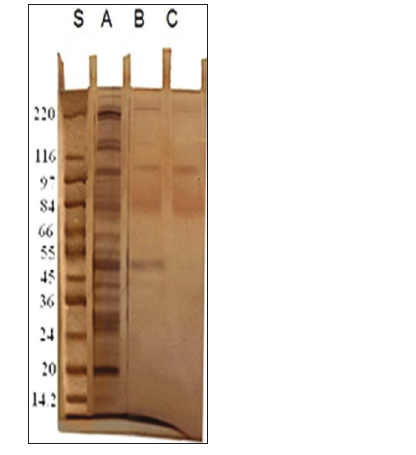
Figure-2: Sodium dodecyl sulfate-polyacrylamide gel electrophoresis analysis of cuticle antigens of adult Toxocara vitulorum lane A, N-acetyl glucosamine (GlcNAc) isolated fraction lane B and glucose isolated fraction (Glc) lane C. Lane S: protein molecular weight marker.